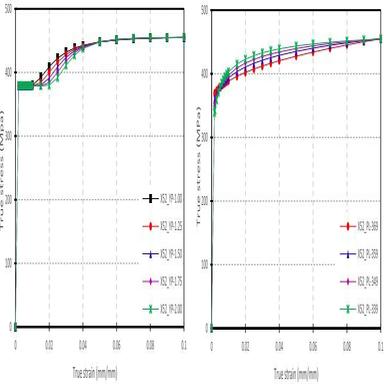
Idealized variations for stress–strain curves of X52-YPT and X52-RHT materials.